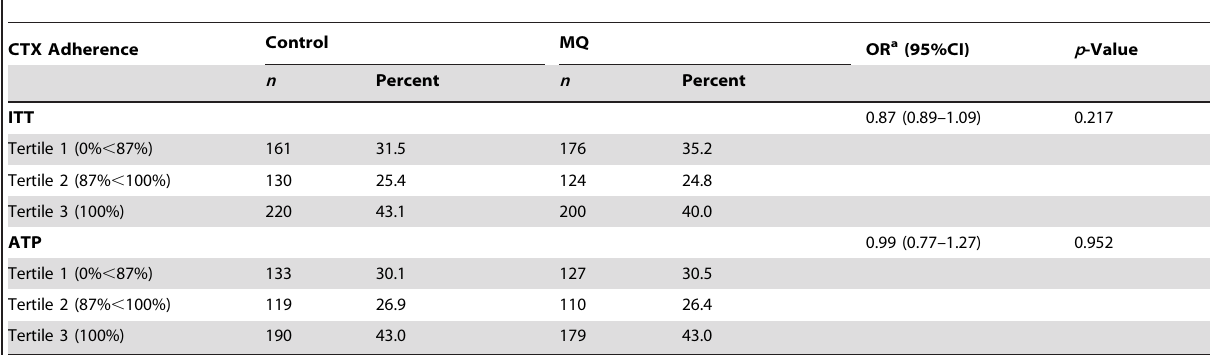
Table 2. Adherence to cotrimoxazole categorized in